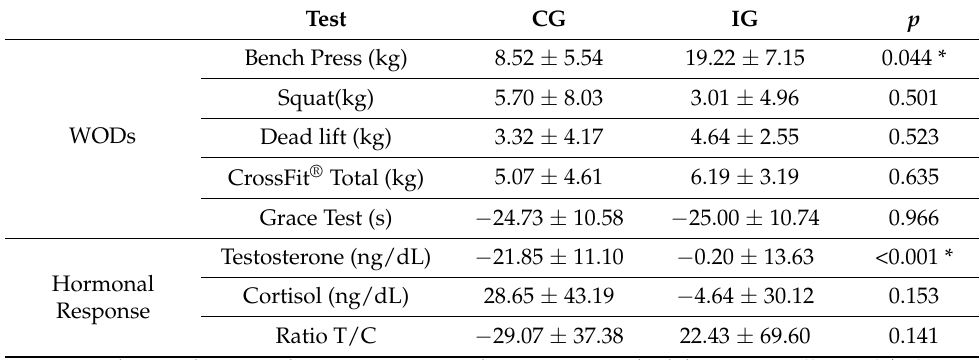
Table 5. Percentage changes during study on Workouts of the Day (WODs) in the two study groups: control group (CG) and intervention group (IG). Test CG